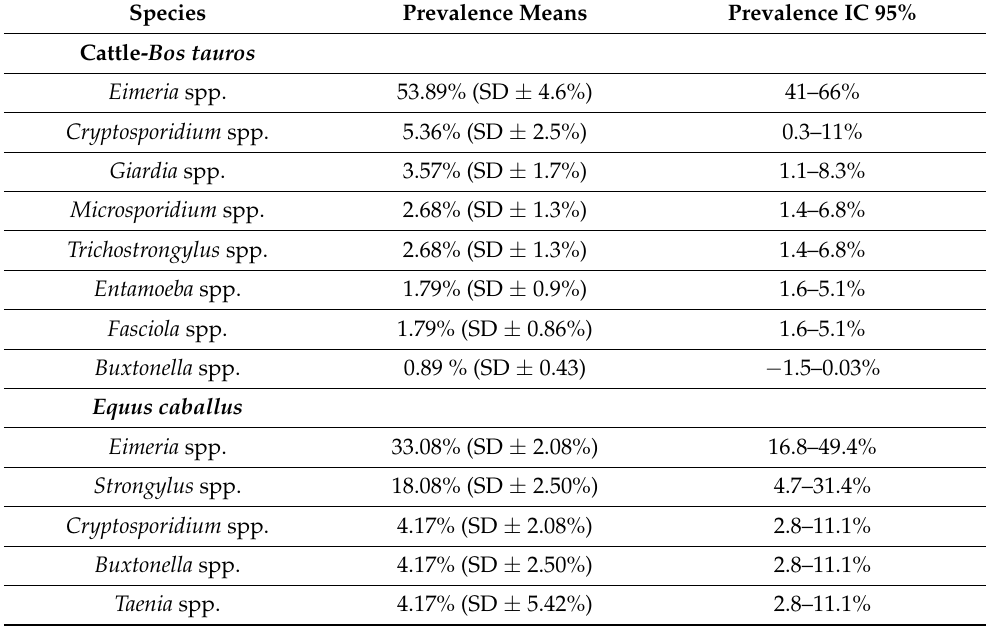
Table 1. Prevalence of endoparasites of domestic animals and T. ornatus in Tolima, Valle del Cauca, and Cauca